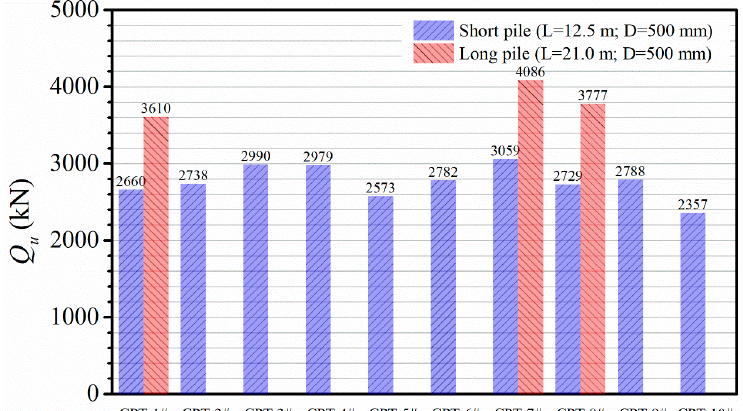
Figure 9. Ultimate bearing capacity based on CPT results.